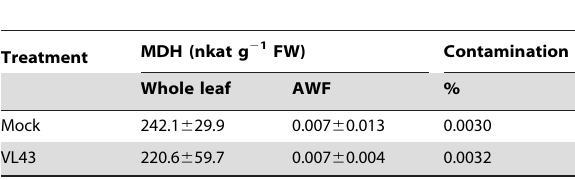
Table 2. Purity of apoplastic washing fluid (AWF) from leaves of mock- and Verticillium longisporum VL43-infected leaves.